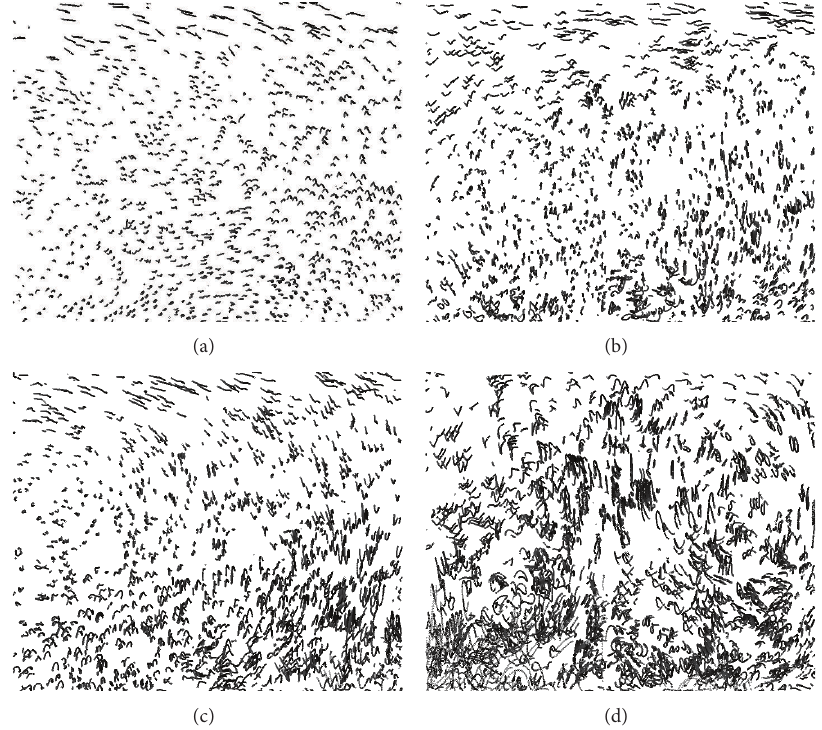
Figure 15: Trajectories reconstructed by FT within the stable layer (case A2; (a) 200 s; (b) 560s; (c) 600 s; (d) 800 s).